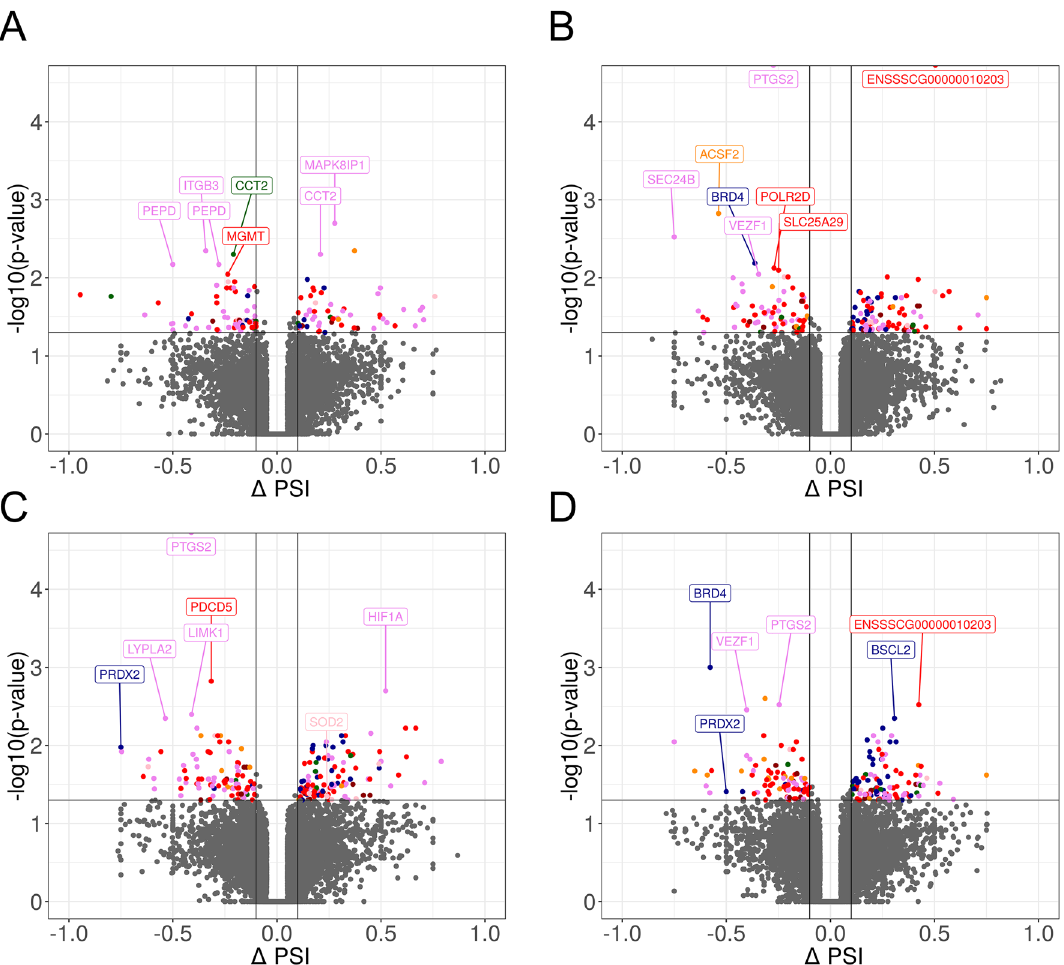
Figure 4. Volcano plot presenting the abundance of alternative splicing events (ASEs) in each experimental comparison: ( A ) LPS versus controls; ( B ) PGJ 2 versus LPS, ( C ) pioglitazone versus LPS; ( D ) T0070907 versus LPS. The ∆PSI values of each ASE are presented on the X-axis, and the negative logarithmic adjusted p -value is presented on the Y-axis. Horizontal lines are equal to the negative logarithmic value of the adjusted p -value cut- off (0.05). Colored dots represent different types of significant DASEs (adjusted p -value < 0.05), and grey dots represent non-significant ASEs. The most interesting DASEs are labeled with gene symbols. The plots generated in maser bioconductor